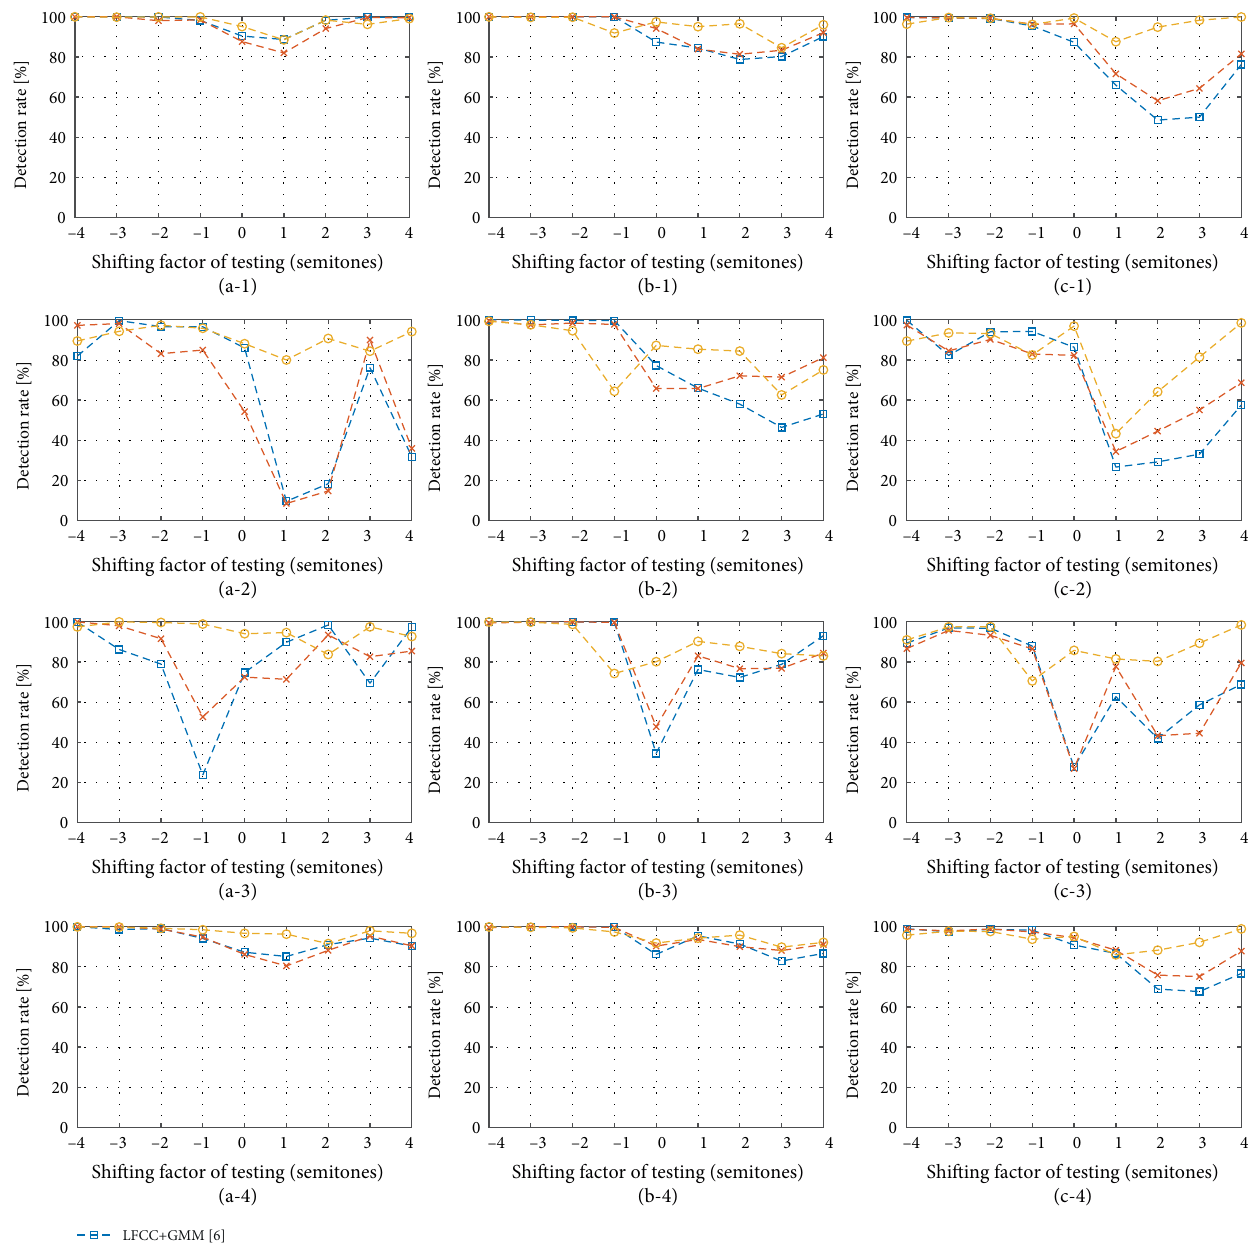
Figure 7: Detection rates of weakly pitch-shifted voice. (a- x ) Voice pitch-shifted by Audition. (b- x ) Voice pitch-shifted by GoldWave. (c- x ) Voice pitch-shifted by Audacity; x represents subfigures in same column . ( y -1) TIMIT for training and TIMIT for testing; ( y -2) TIMIT for training and UME for testing. ( y -3) UME for training and TIMIT for testing. ( y -4) UME for training and UME for testing; y represents subfigures in same